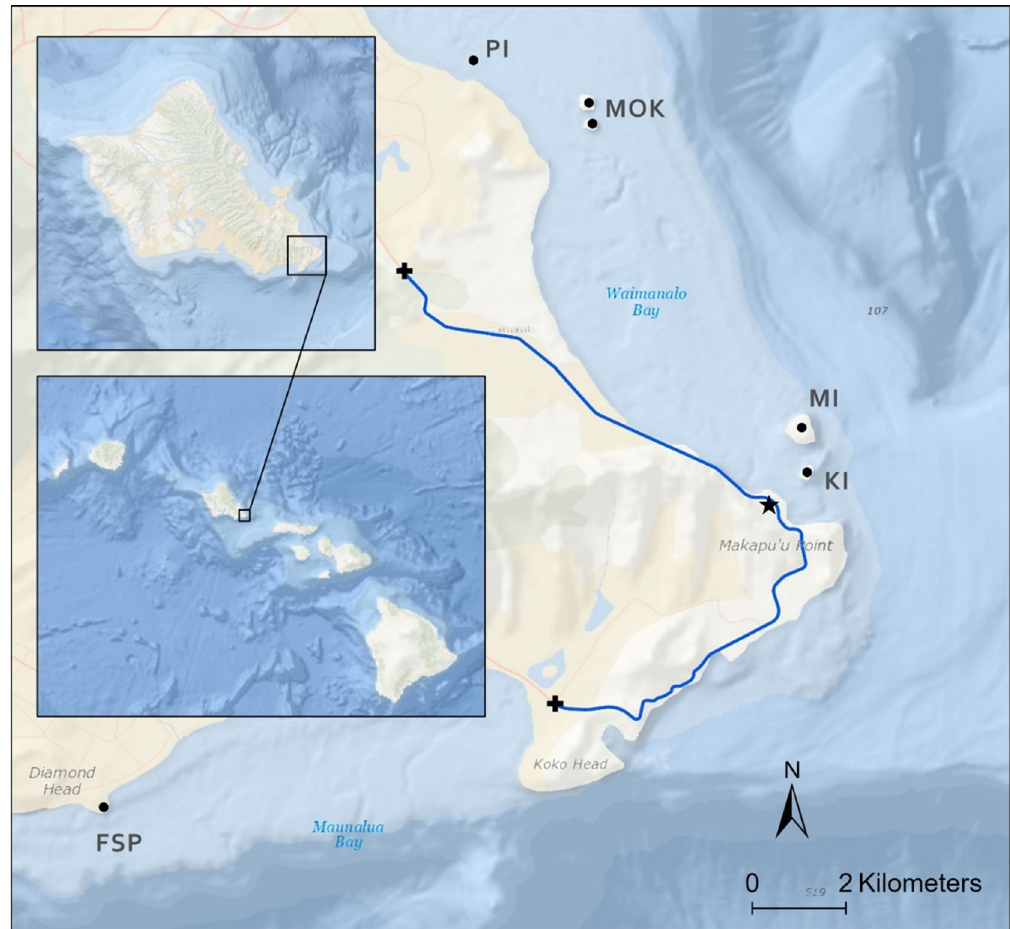
KI = K ā ohikaipu Island, FSP = Freeman Seabird Preserve). Star marks the location of the Sea Life Park seabird rehabilitation center. Inset maps show the island of O‘ahu, and the main Hawaiian Islands. Map features are overlaid on an ArcGIS Pro Software Version 2.5 base layer